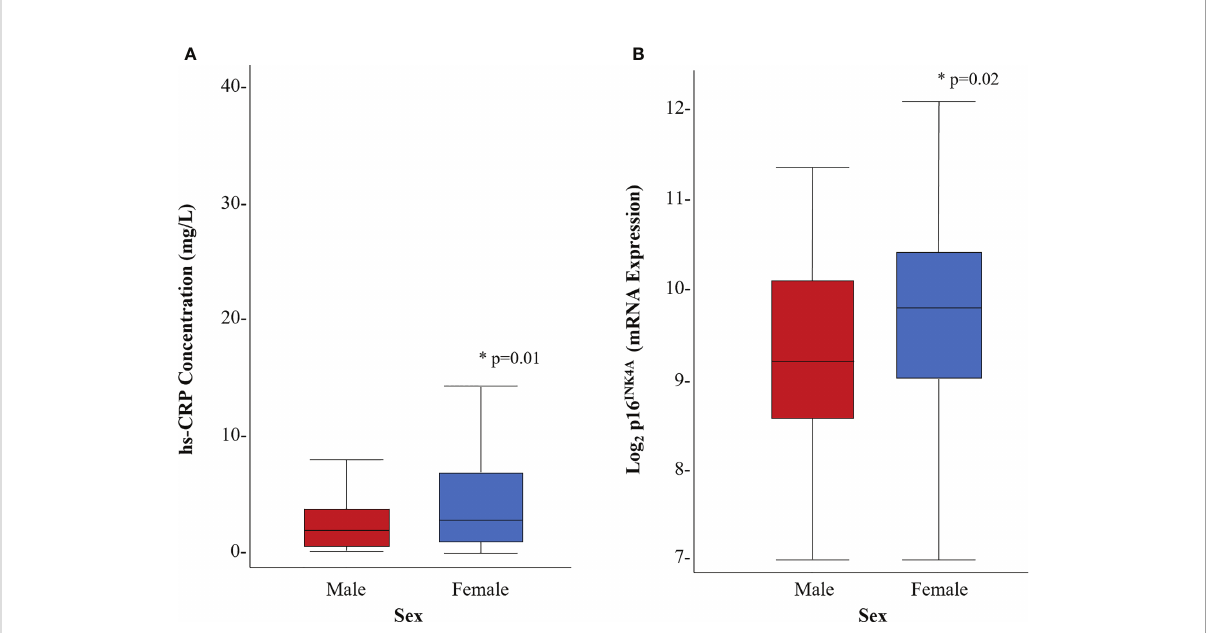
FIGURE 2 Distribution of biomarkers of in fl ammation and cellular senescence by sex. (A) hs-CRP concentration (mg/L) (B) p16 INK4A expression. * denotes statistical signi fi cance at